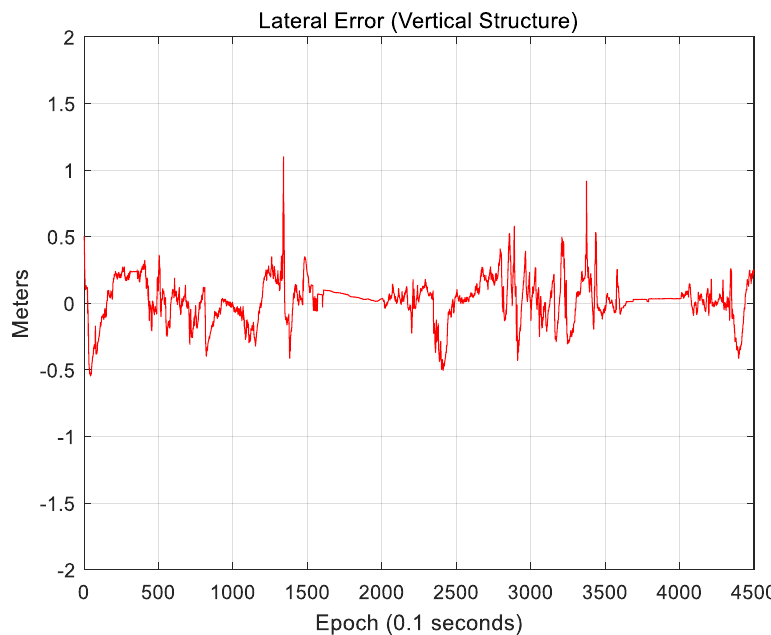
Figure 27. Lateral position error (vertical structure).